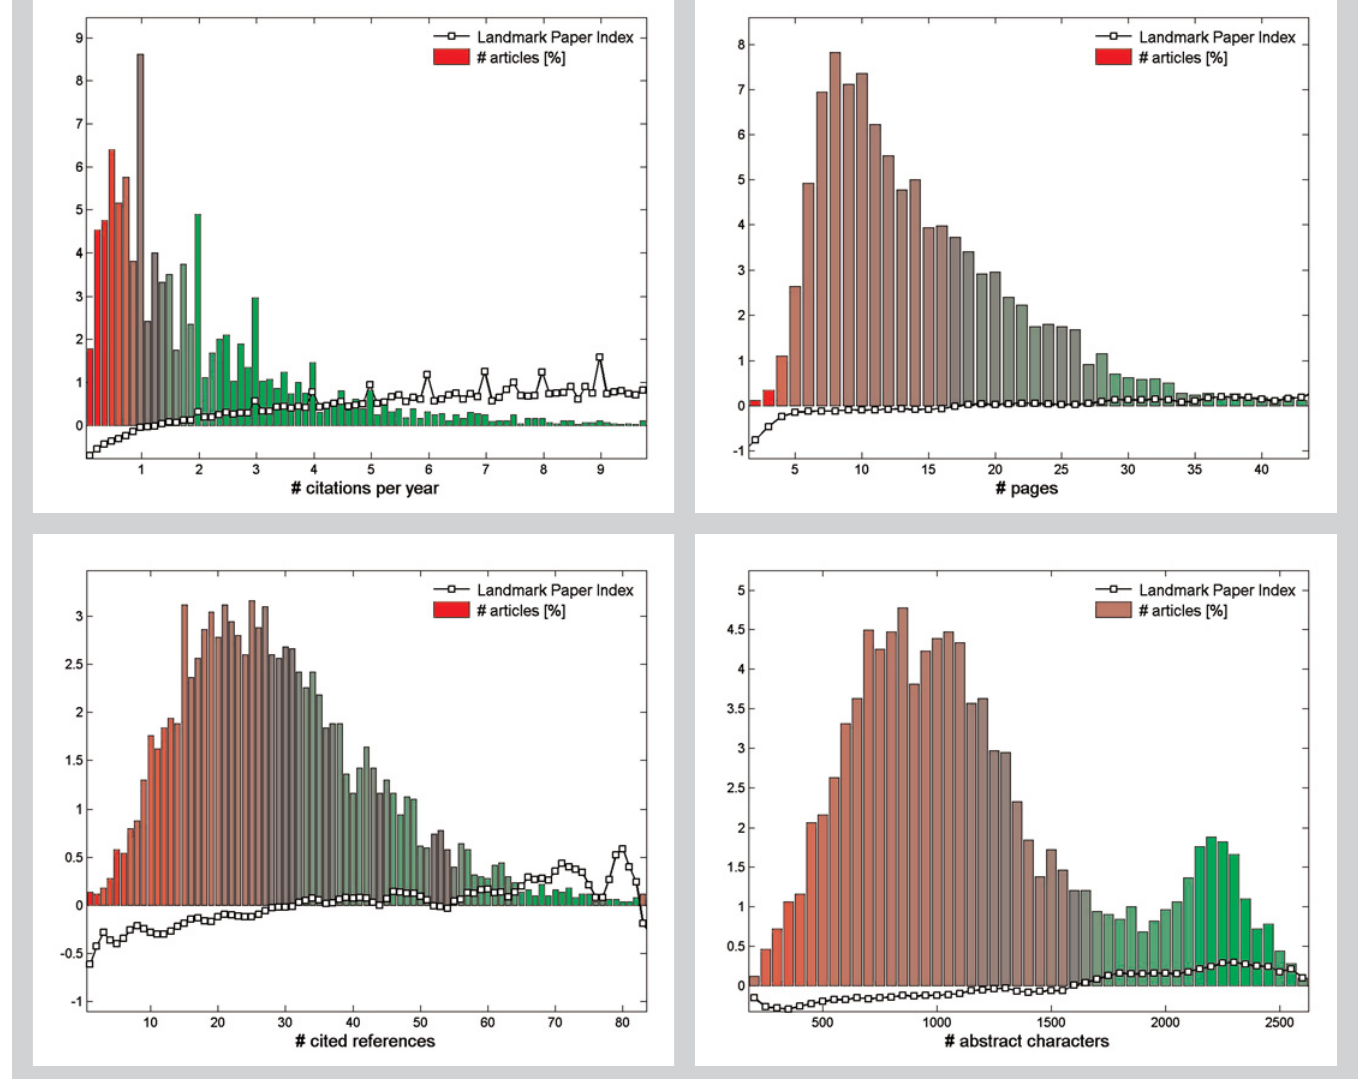
Figure 3 (left above): Total number of citations divided by number of years after the year of publication versus LPI. Figure 4 (right above): Number of article pages and their correlation with the LPI. Figure 5 (left below): Number of cited references and their correlation with the LPI. Figure 6 (right below): Number of characters in the abstract of scientific articles versus